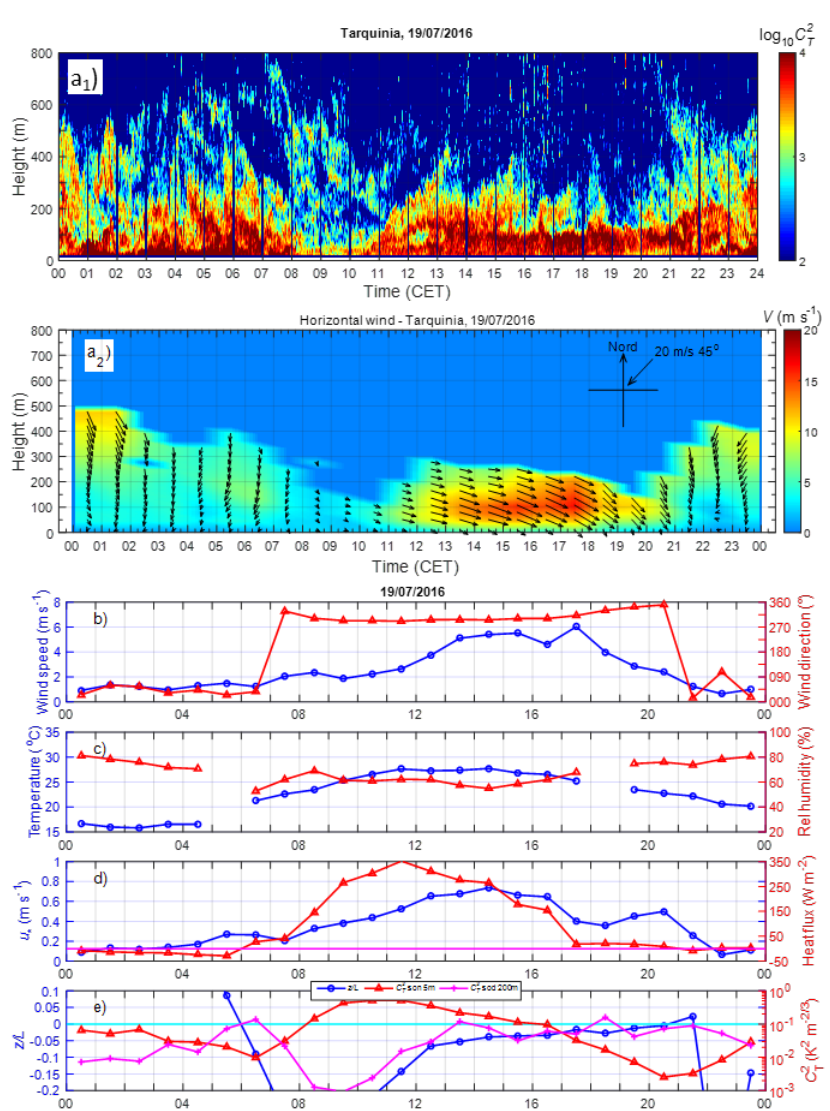
Figure 18. Example of the diurnal variation of the ( a 1 ) ABL thermal turbulence and ( a 2 ) wind field structures; ( b ) wind speed and direction at 5 m; ( c ) temperature and relative humidity; ( d ) friction velocity and sensible heat flux; and ( e ) the stability parameter z / L at 5 m and the temperature structure parameter C T 2 at 5 m (from the sonic anemometer) and at 200 m (from the sodar in arbitrary units) on 19 July 2016.